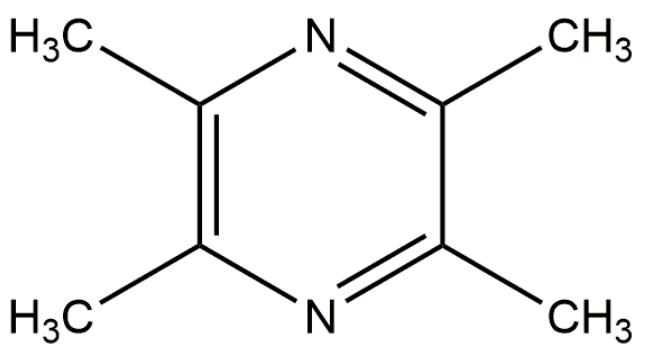
Figure 1. Chemical structure of tetramethylpyrazine (TMP) (ChemDraw ® Ultra Ver. 10.0; CambridgeSoft, Cambridge, MA, USA).